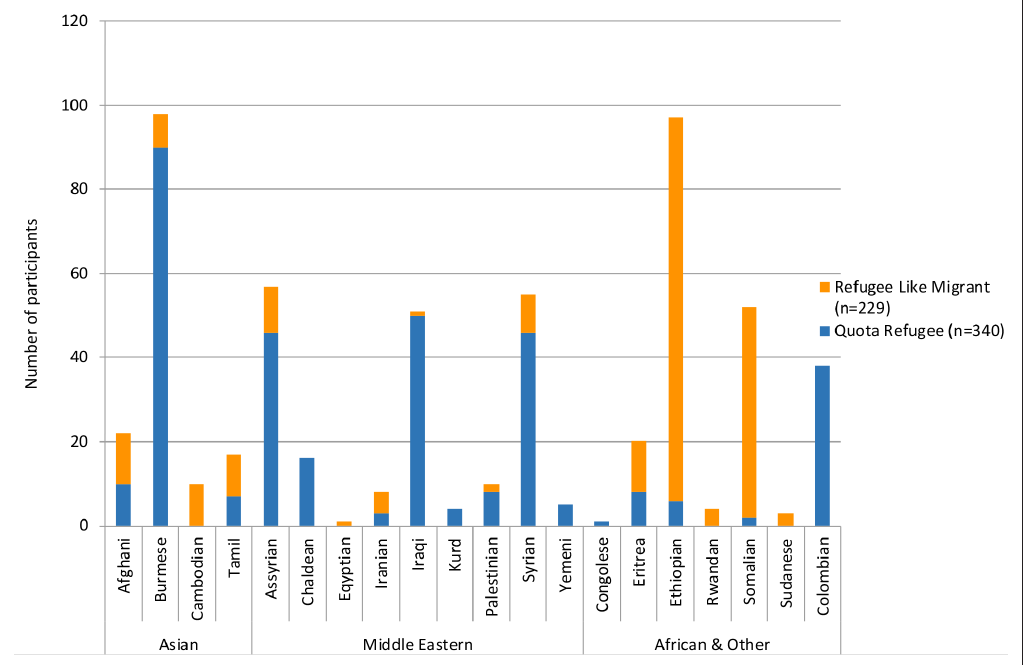
Figure 1 Refugee- like migrants and quota refugees by self- identified ethnic